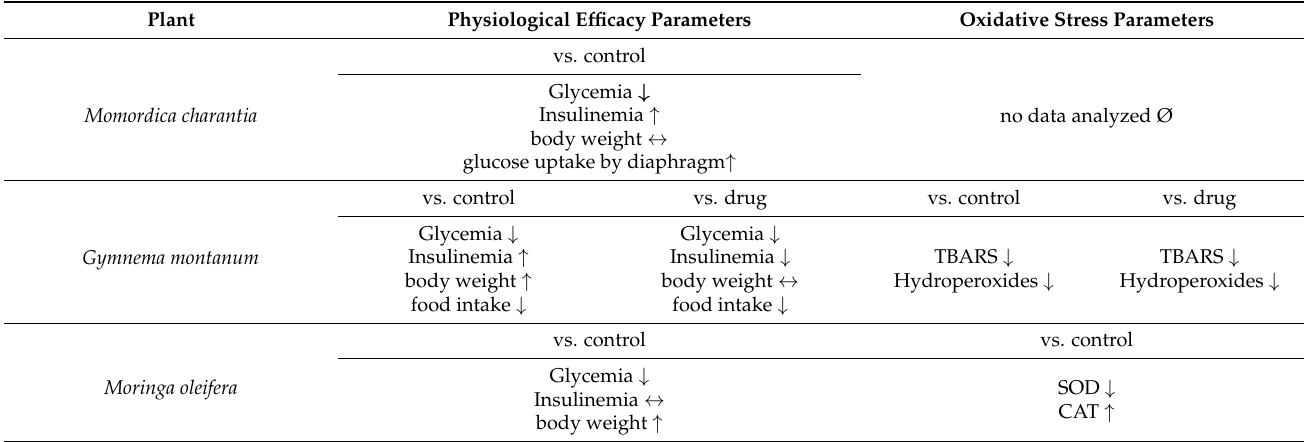
Table 2. Distribution and changes of analyzed parameters in